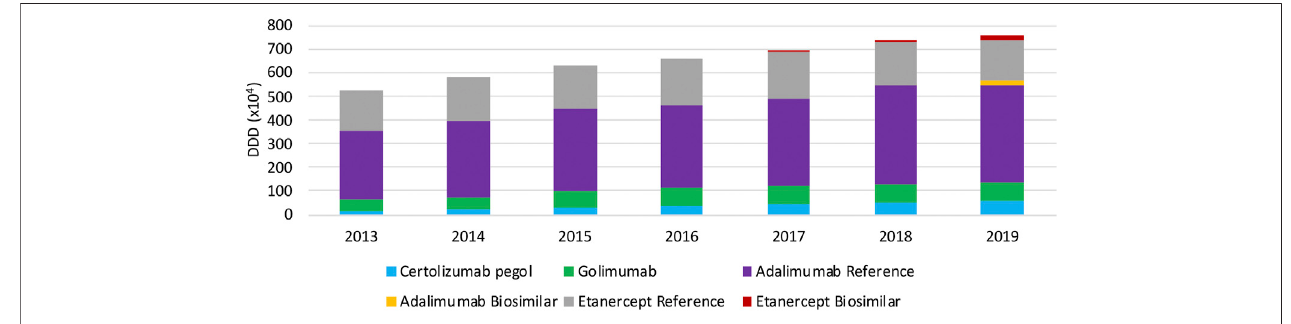
FIGURE 1 | Total volume (DDD) evolution of SC TNF inhibitors between 2013 and